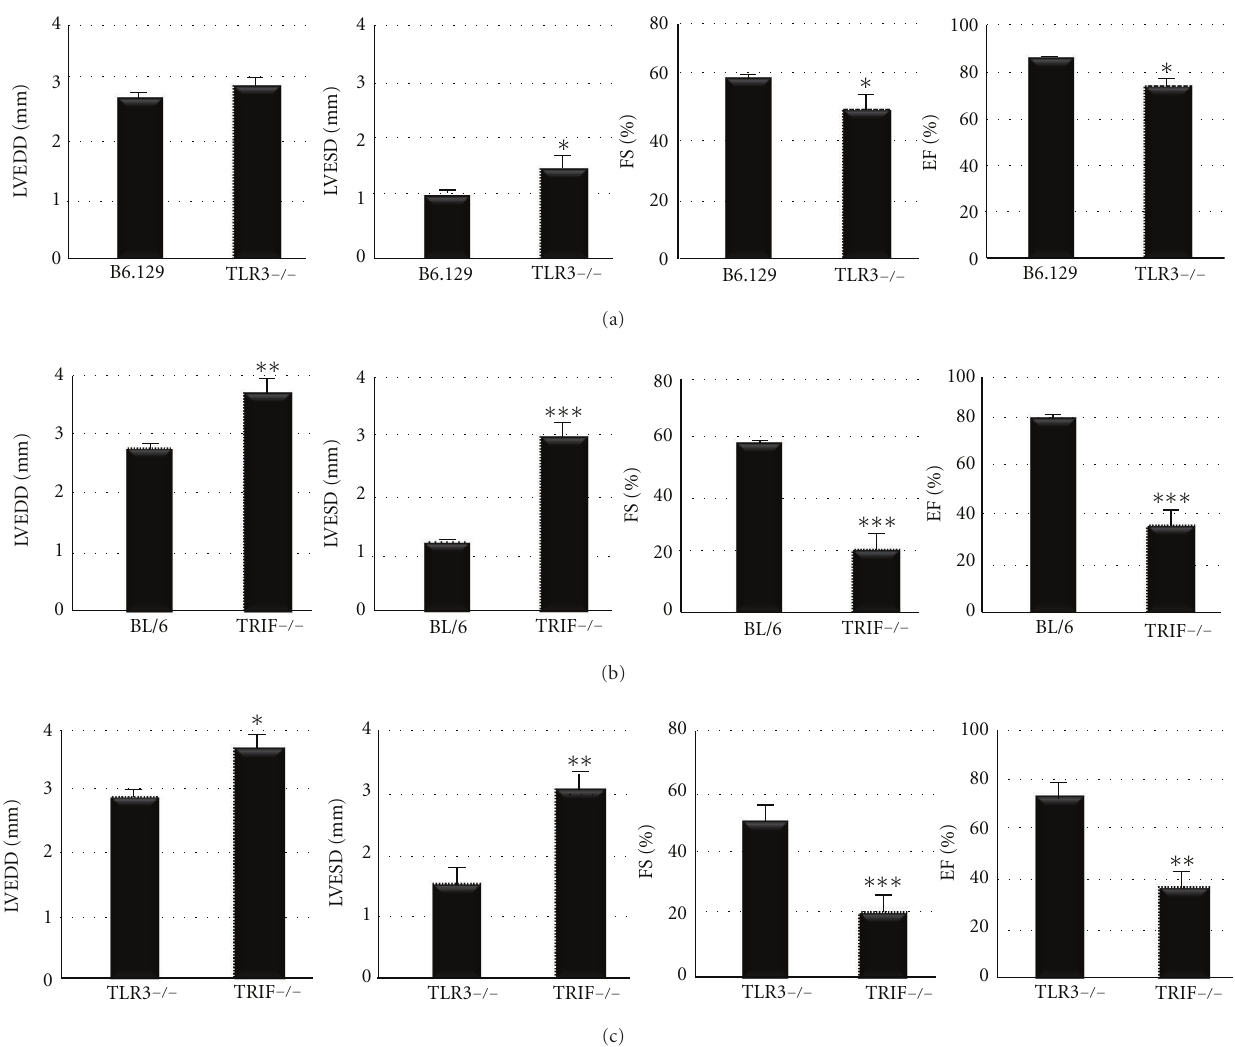
Figure 3: TRIF-deficient mice develop significantly worse heart function at day 10 pi. Echocardiography was used to assess heart function in (a) TLR3-deficient (TLR3 − / − ) versus WT B6.129 mice, (b) TRIF-deficient (TRIF − / − ) versus WT BL/6 mice, or (c) TLR3- versus TRIF- deficient mice. LVEDD, left ventricular end diastolic dimension; LVESD, left ventricular end systolic dimension; FS, fractional shortening; EF, ejection fraction. Data show the mean ± SEM of at least three separate experiments using 7 to 12 mice/group. ∗ : P < 0 . 05; ∗∗ : P < 0 . 01; ∗∗∗ : P < 0 .